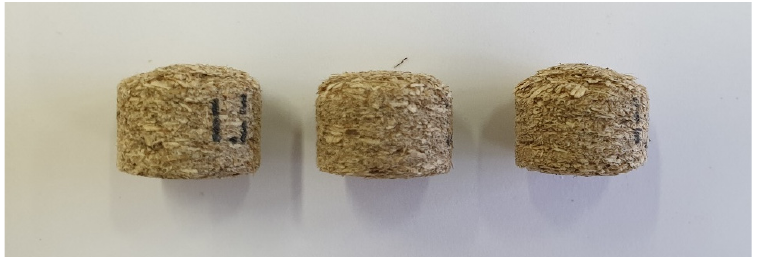
Figure 8. Samples after mechanical durability test-Sida.